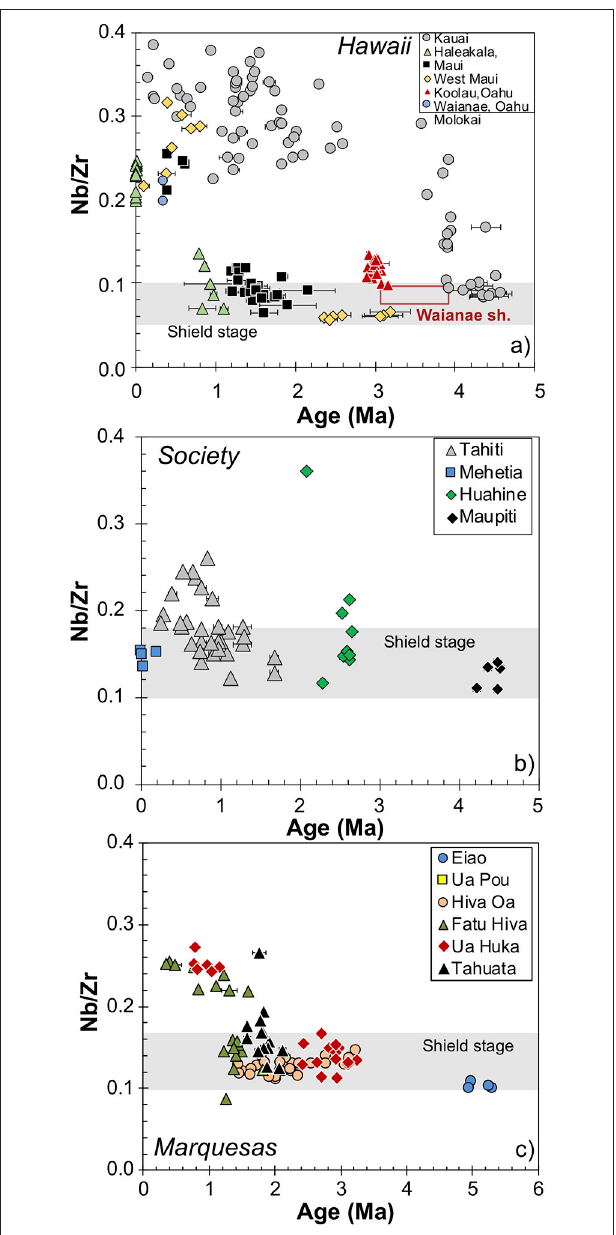
FIGURE 6 | Variation of the Nb/Zr ratios in the lavas with age for the best-studied volcanoes of the (a) Hawaii, (b) Society, and (c) Marquesas hotspots. Note that error bars are shown for most ages but are typically smaller than the symbols. The chemical variation of the lavas with age implies changes in the magma formation and mantle source. The red box in (a) indicates the range of eruption ages and compositions of the shield lavas at Waianae volcano. Note also that there is considerable overlap between shield stage volcanism and later more enriched postshield or rejuvenated volcanism in Kaua’i, Tahiti, Huahine, Tahuata, and Fatu Hiva. Data sources can be found in the Supplementary Material